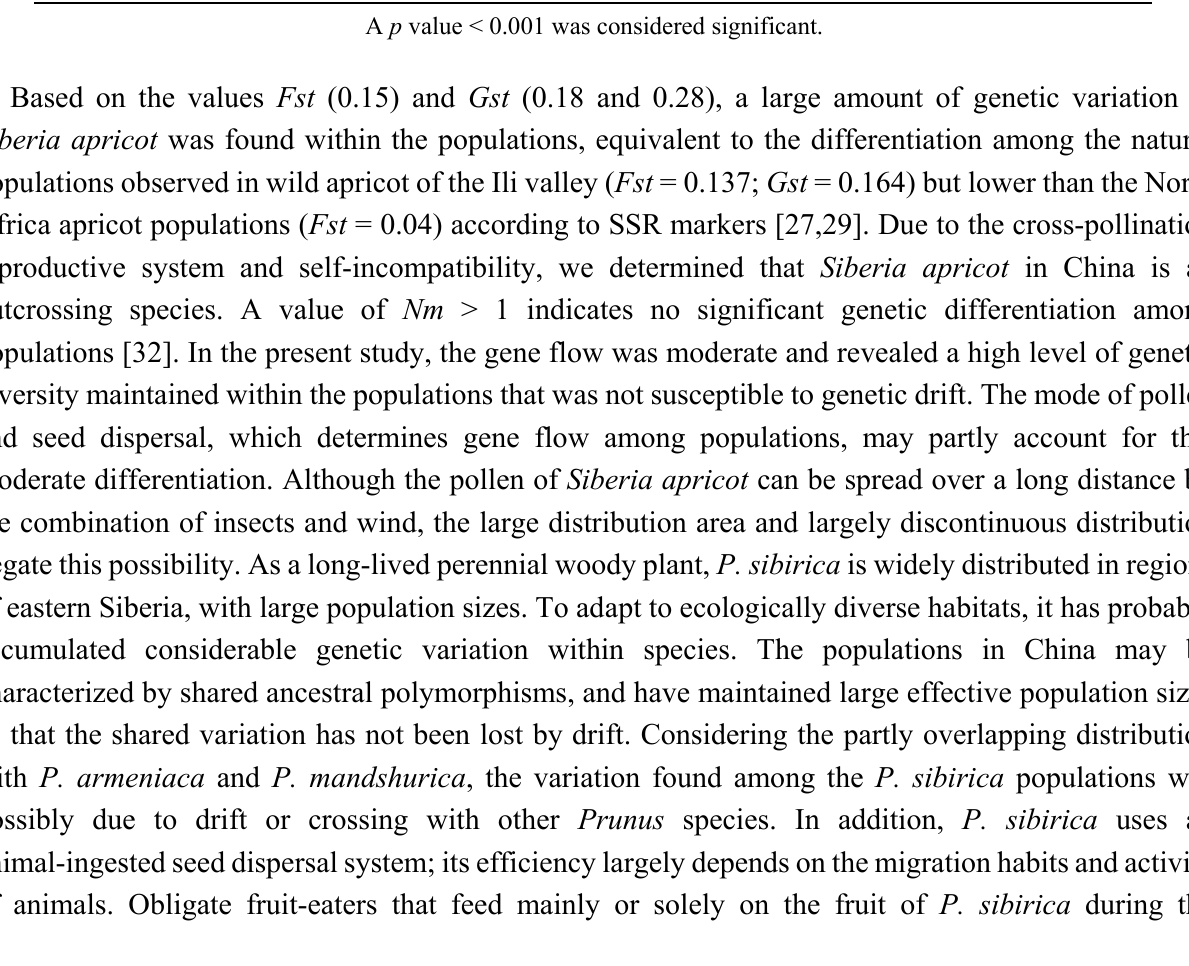
Table 2. Analysis of molecular variance (AMOVA) within/among Siberian apricot populations. Source of variance Among populations Within populations